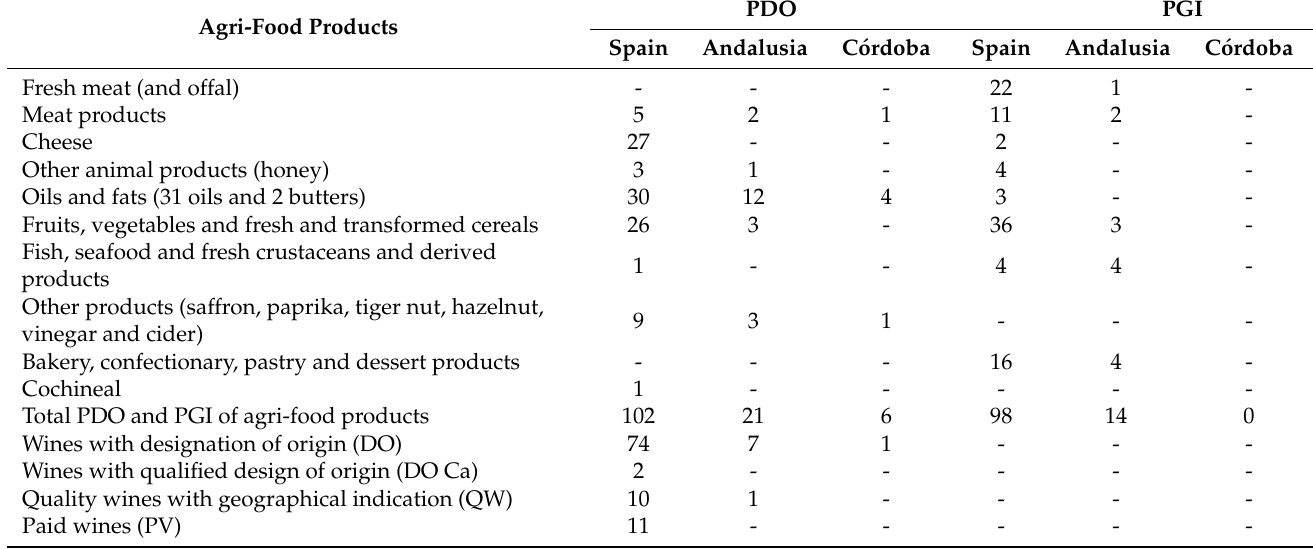
Table 1. Distribution of agri-food products, wines and spirits with PDOs and PGIs in Spain, Andalusia and C ó rdoba (July